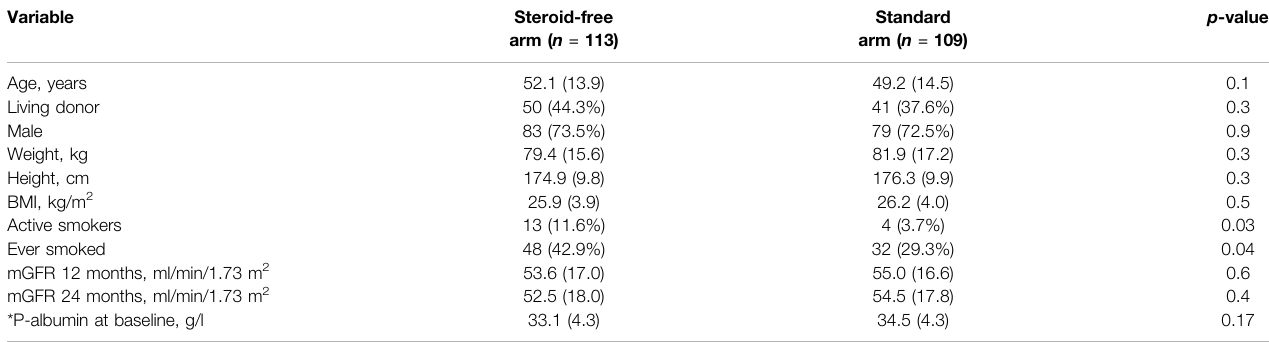
TABLE 1 | Patient characteristics and demographics. Variable